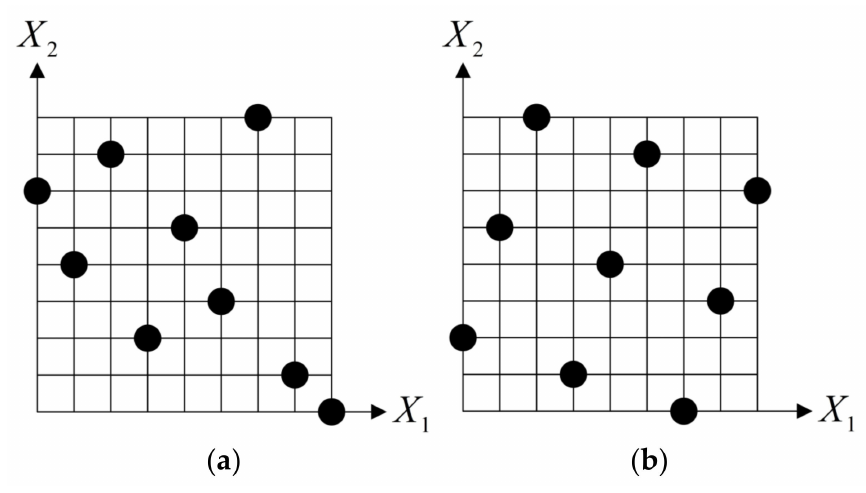
Figure 7. Comparison of the sampling effects of LHS and OLHS: ( a ) LHS; ( b ) OLH.